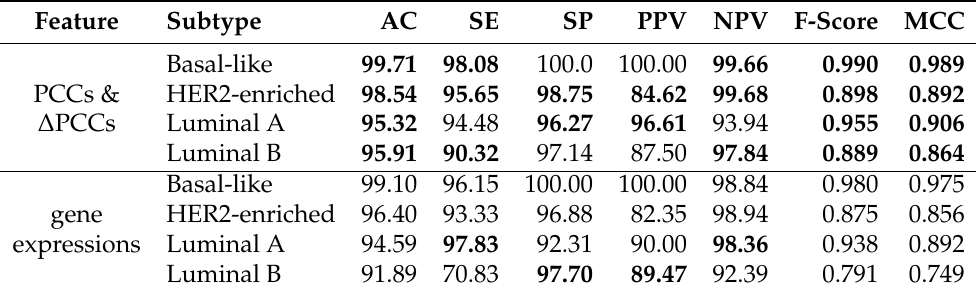
Table 4. Comparison of two models with different features in classifying subtypes of breast cancer. A better performance is shown in bold. AC: accuracy, SE: sensitivity, SP: specificity, MCC: Matthews Correlation